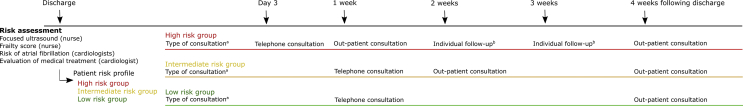
The Intervention; Risk assessment at discharge and planned consultations. Risk assessment and follow-up during the intervention period. a All consultations after discharge were nurse-led with clinical back-up as needed (cardiologist or heart surgeon). b Individual follow-up according to symptoms leading to; no consultation, telephone- or out-patient consultation.